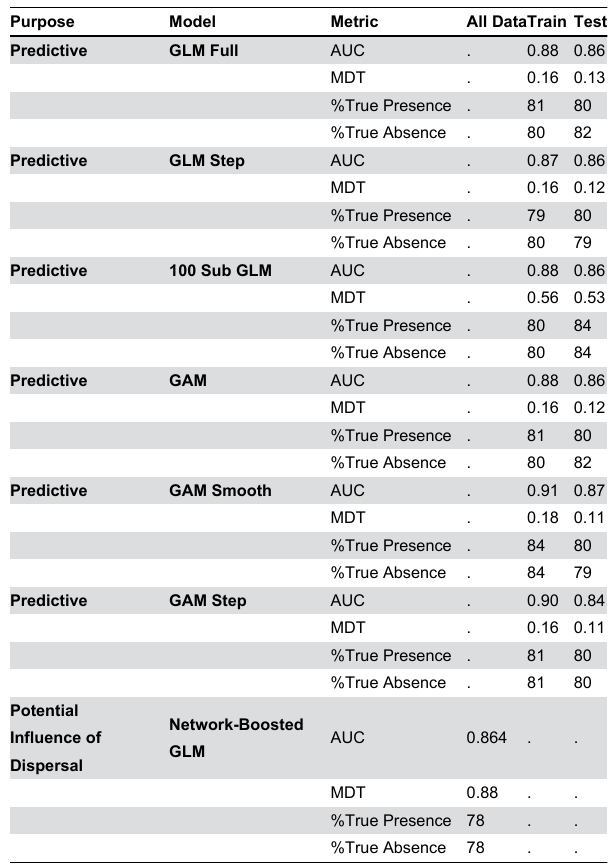
Table 2. AUC scores, Maximum Discrimination Threshold (MDT) probabilities (the model probability threshold that maximizes both true presences and true absences), and the true presence and true absence rate for the three General Linear Models, three General Additive Models, and the Network-Boosted GLM.